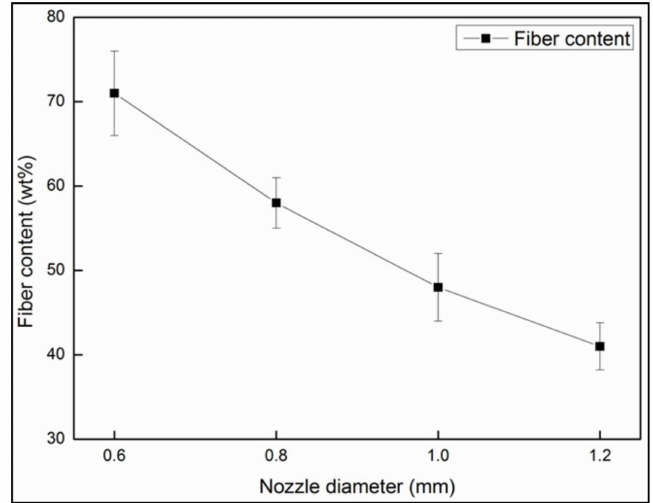
Figure 7. The influence of nozzle diameter on the fiber content in CFRTPCs.